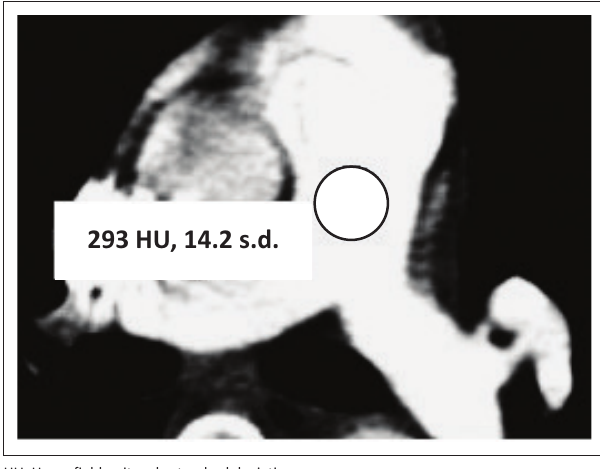
FIGURE 1: Contrast enhancement: Hounsfield unit measurement in the main pulmonary artery: 293 HU (adequate